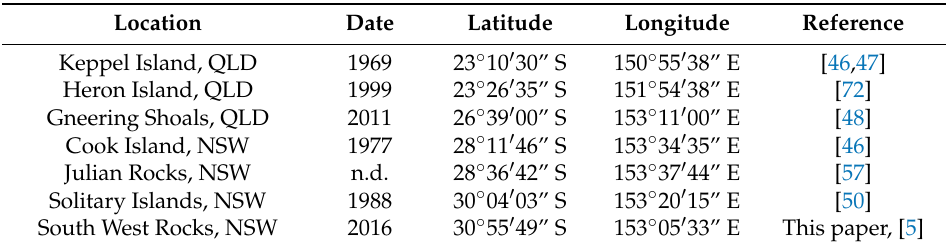
Table 9. Eastern Australian distribution records of Phyllodesmium magnum